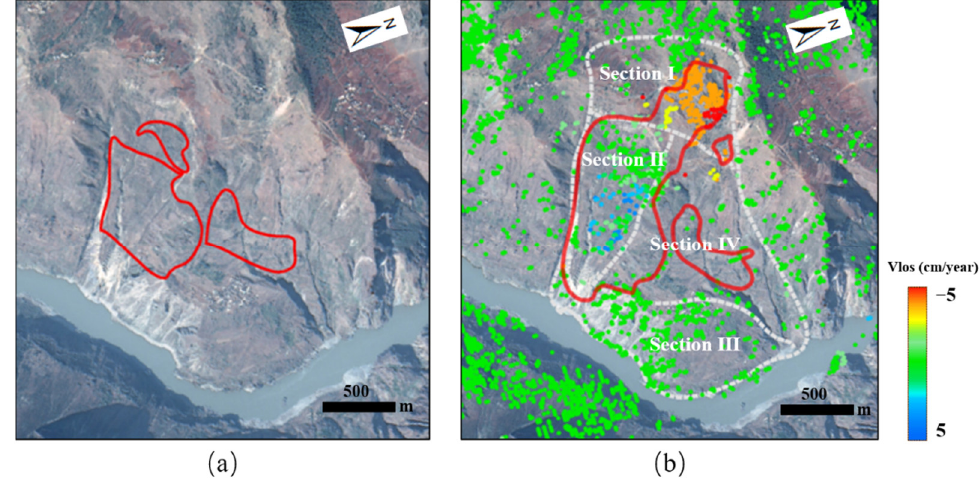
Figure 7. Identification results (red polygons) of the JPZ landslide with the OBIA method by using a purely optical image ( a ), and by integrating the optical image with the InSAR − derived deformation map ( b ). The white polygons in ( b ) represent five subsections of the JPZ landslide. (b) SLT landslide